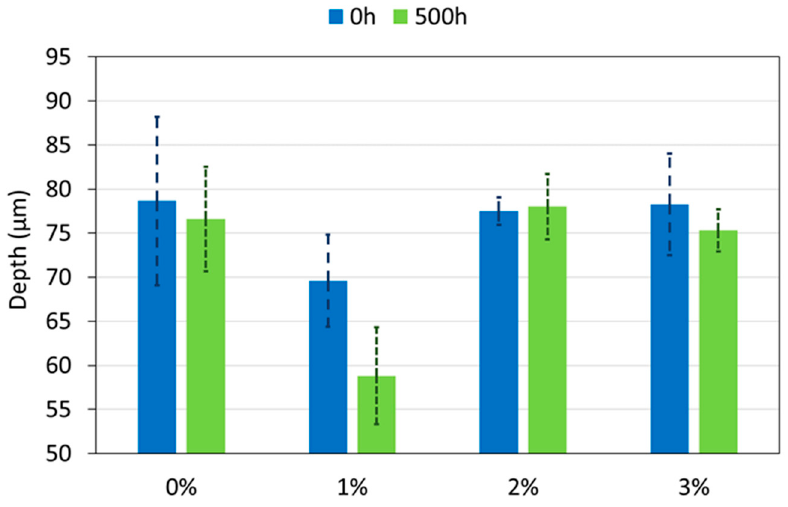
Figure 9. Depth of the wear tracks of all organic coatings at 0 and 500 h of exposure.